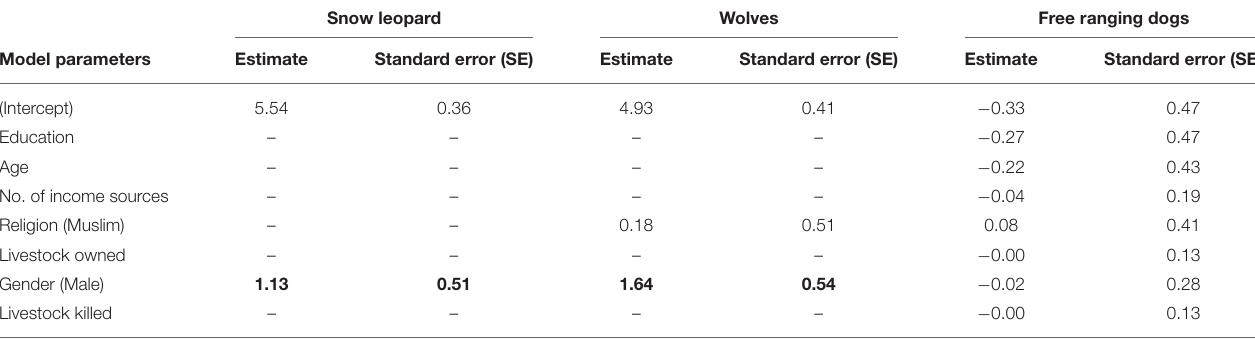
TABLE 3 | Summary of estimates of coefficients using the best fit models for determinants of attitudes toward wild carnivores and free ranging